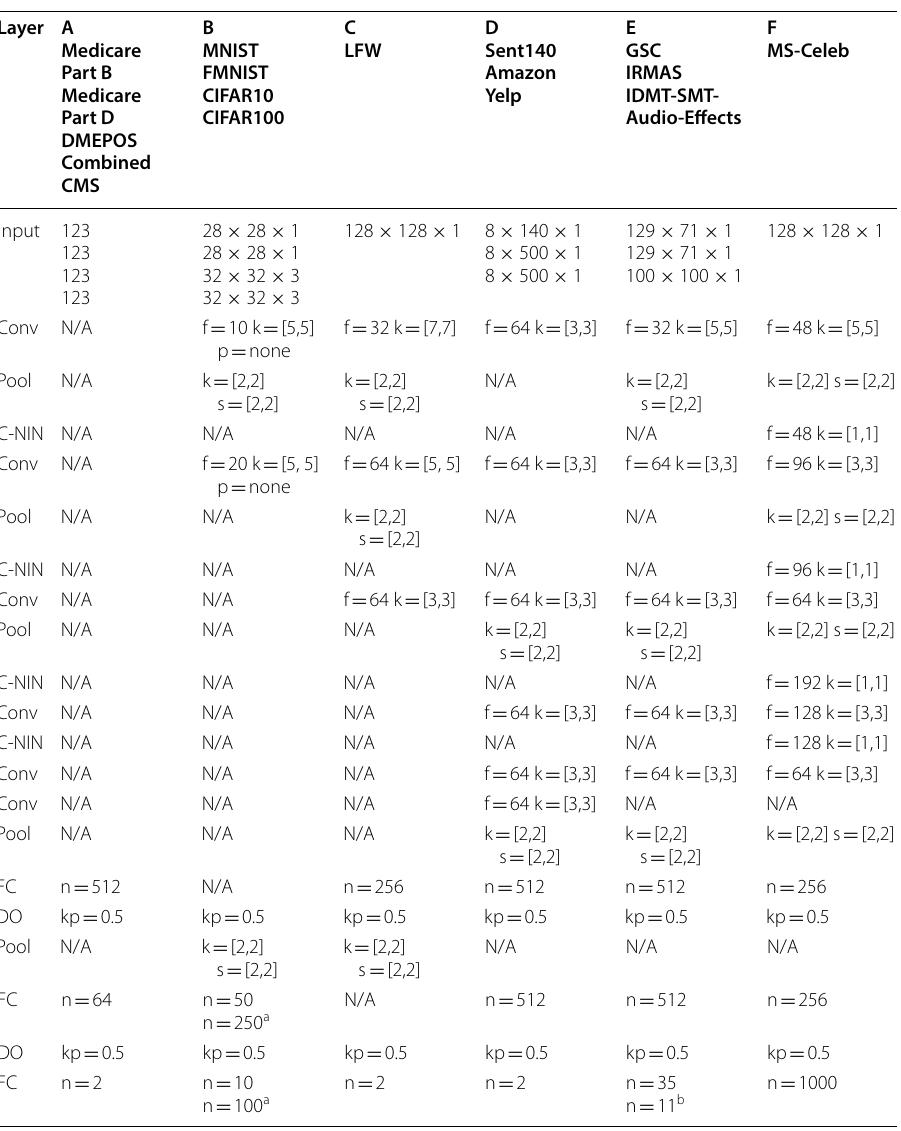
Table 1 CNN and NN